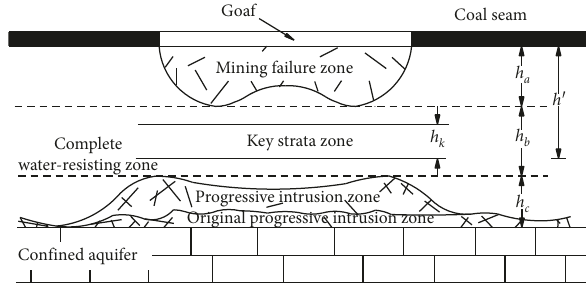
Figure 8: Depth of the mining failure of the